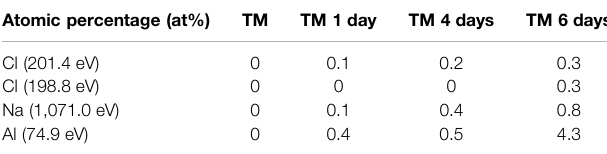
TABLE 4| ThecontentofCl(fromCl 2ppeaks),Na(fromNa 1speak)and Al(from Al 2p peaks), given in atomic percentage (at %), determined from high energy resolution XPS spectra for TM coating before and after immersion for selected times in 0.1 M NaCl solution (1, 4, and 6 days). Atomic percentage (at%)